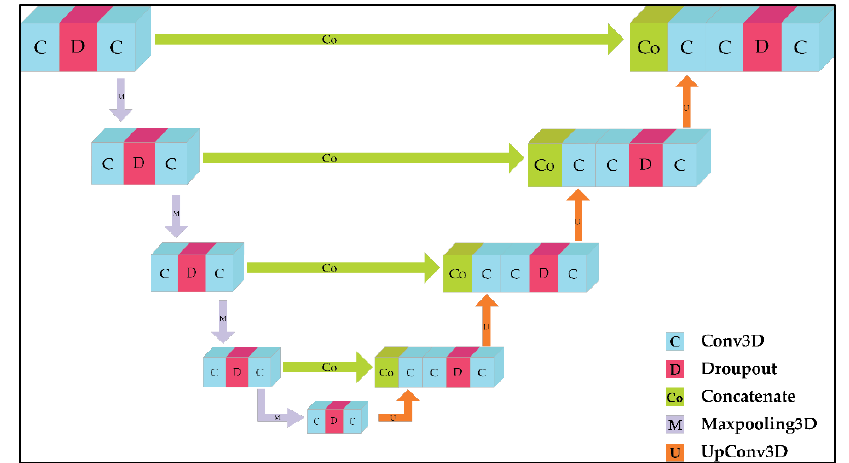
Figure 1. 3D UNet architecture.